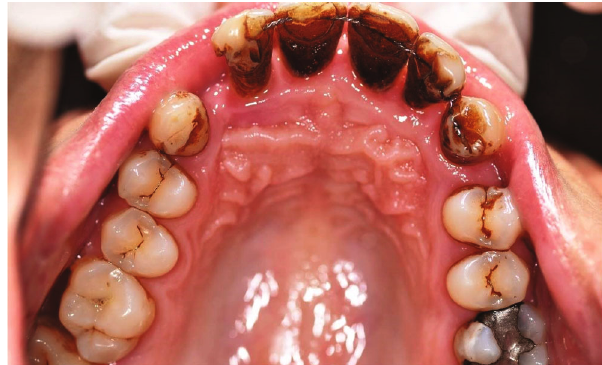
Figure 2: Clinical case: occlusal view, lower jaw.